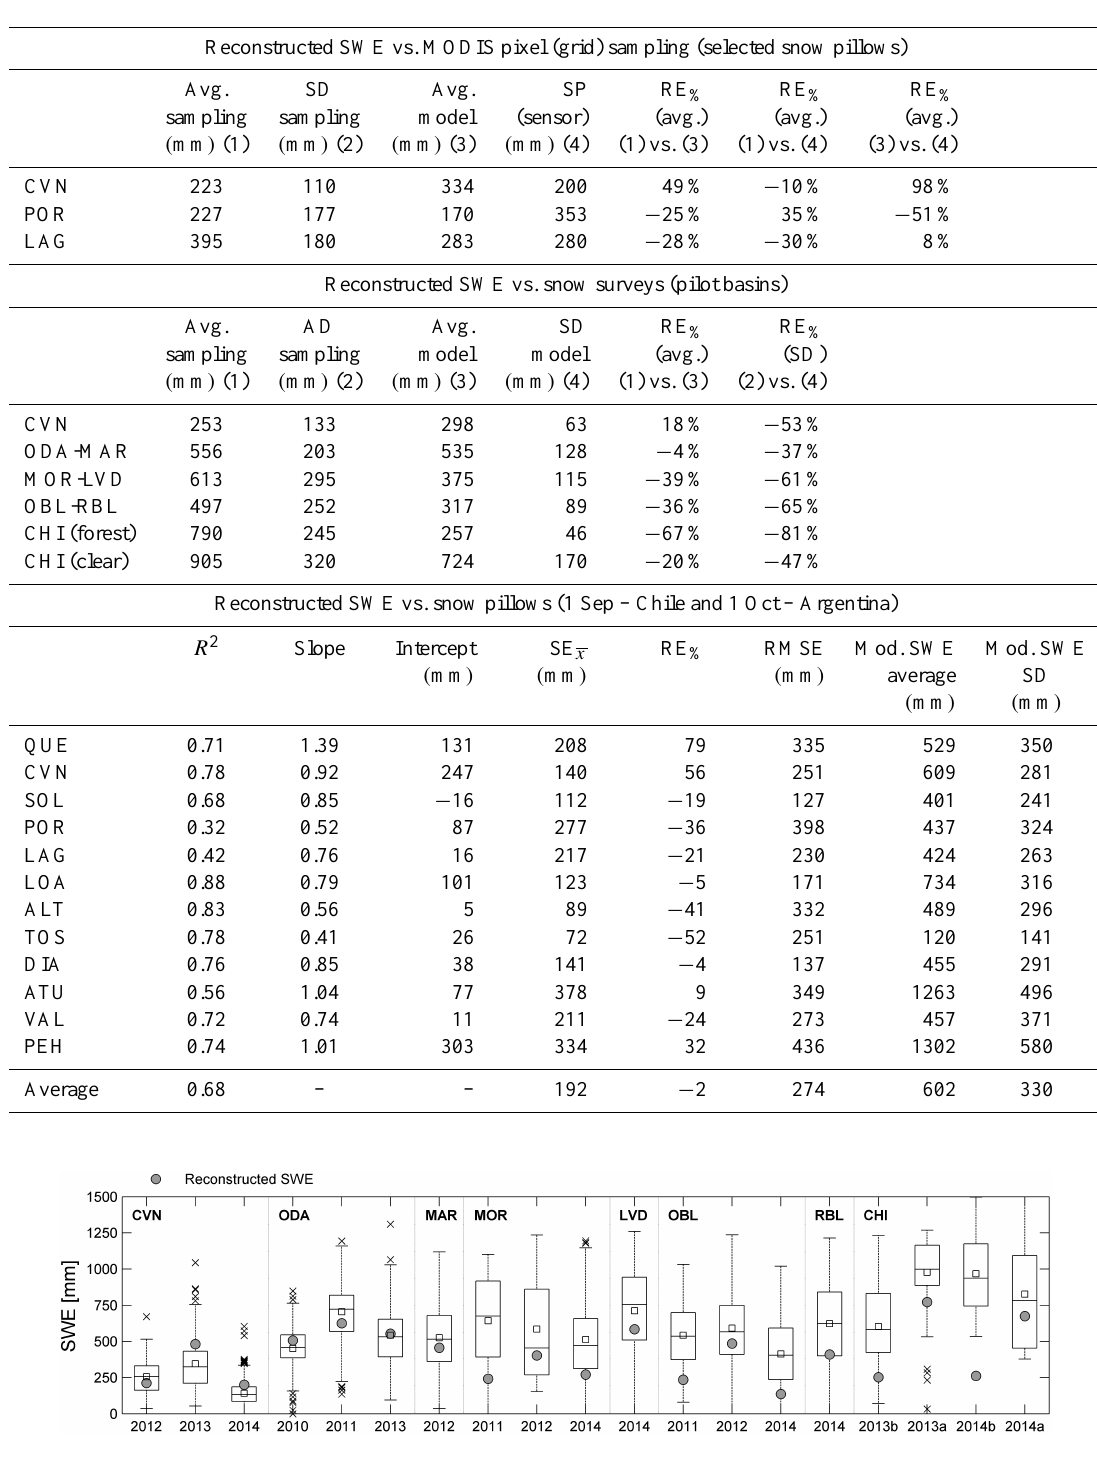
Figure 4. Reconstructed SWE validation at pixels with snow survey data. Box plots summarize all individual measurements at pixels co- located with SWE reconstruction. Symbology analogous to Fig.